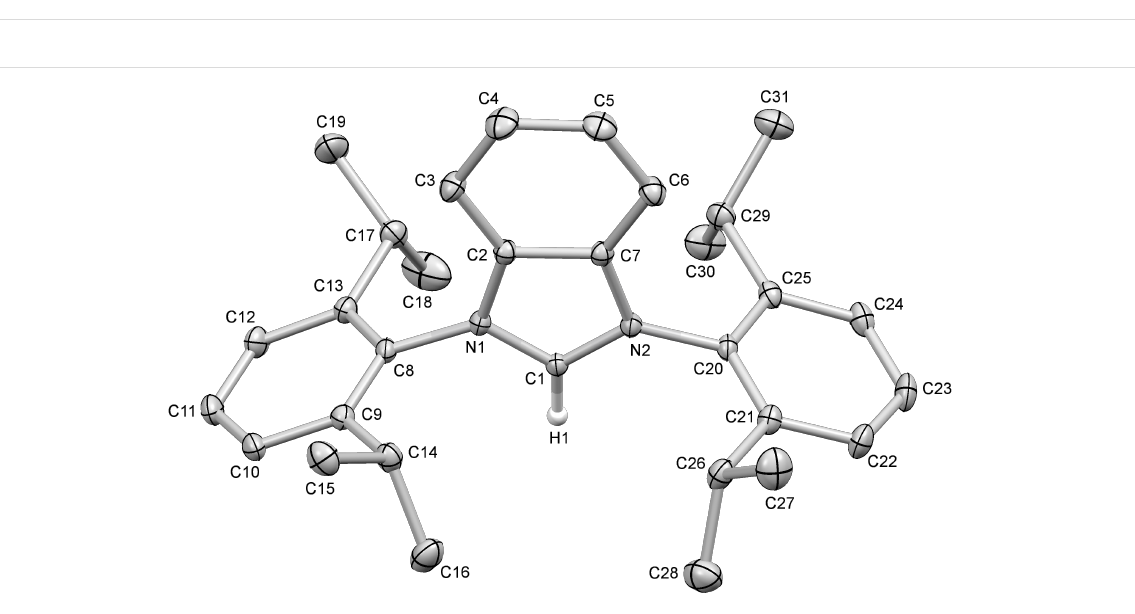
overall reaction time (19 hours) and the low number of steps (2) together with the fact that this is the only way to access this compound, makes the given route an acceptable synthetic